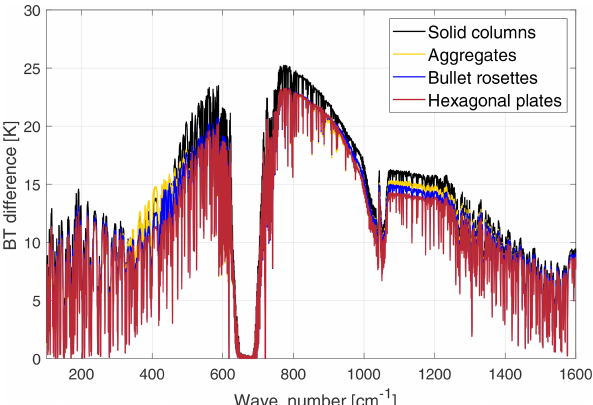
Figure 5. Brightness temperature sensitivity to cirrus cloud crystal habit. The crystal’s habits assumed are reported in the legend. The simulated tropical cirrus cloud is 2km thick, with optical depth 1 and with an effective dimension equal to 32µm. The BT differences are obtained in reference to a tropical clear-sky case over the ocean.